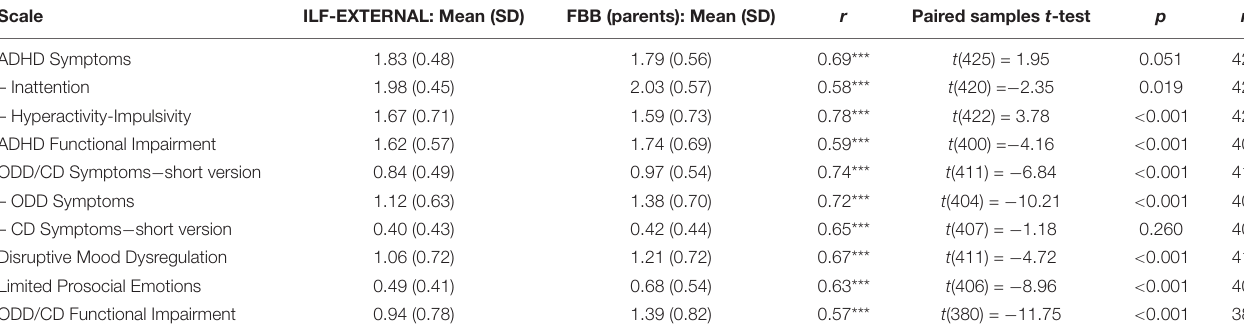
TABLE 5 | Comparisons of the ILF-EXTERNAL scales and the corresponding parent forms (FBB-ADHS and FBB-SSV).